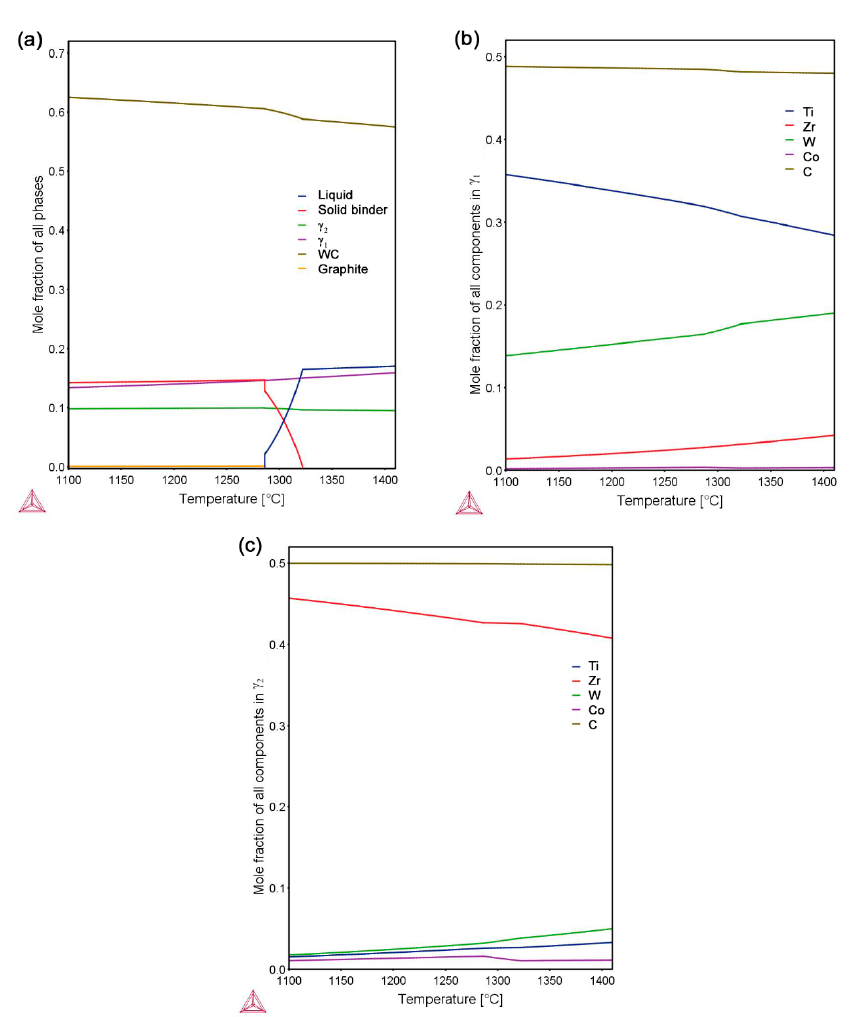
Figure 1. ( a ) Mole-fraction of stable phases in the WC-TiC-ZrC-Co system and equilibrium composition of ( b ) γ 1 and ( c ) γ 2 versus temperature predicted from thermodynamic calculations using Thermo-Calc and the TCFE8 database.